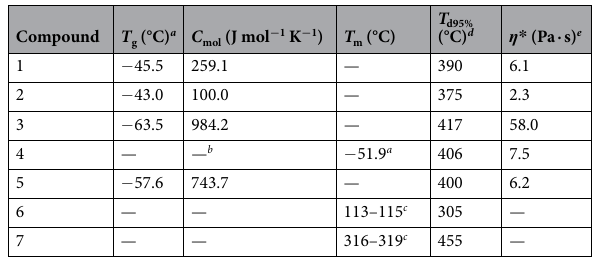
Table 1. Physical characteristics ( T g : glass transition temperature; C mol : molar heat capacity; T m : melting point; T d95% : decomposition temperature at 95% weight loss; η * : complex viscosity) of 1 – 7 in solvent-free state. a Determined by the second heating scan of a DSC measurement. Scan rate: 10 °C min − 1 under N and entropy of 4 at melting were determined as Δ H = 38.6 kJ mol − 1 and Δ S = 174.5 J mol − 1 K − 1 , respectively. c Determined by melting point apparatus. d Decomposition temperatures at which 5% weight loss occurred on TGA. e Determined at angular frequency ω = 10 rad s − 1 at 25